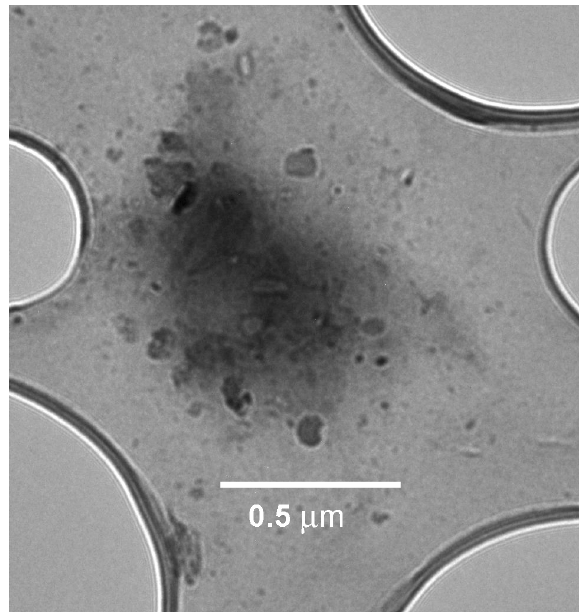
Fig. 13. TEM image of one of the residual particles from the CVI, showing the presence of inclusions in amorphous organic material. See text for more